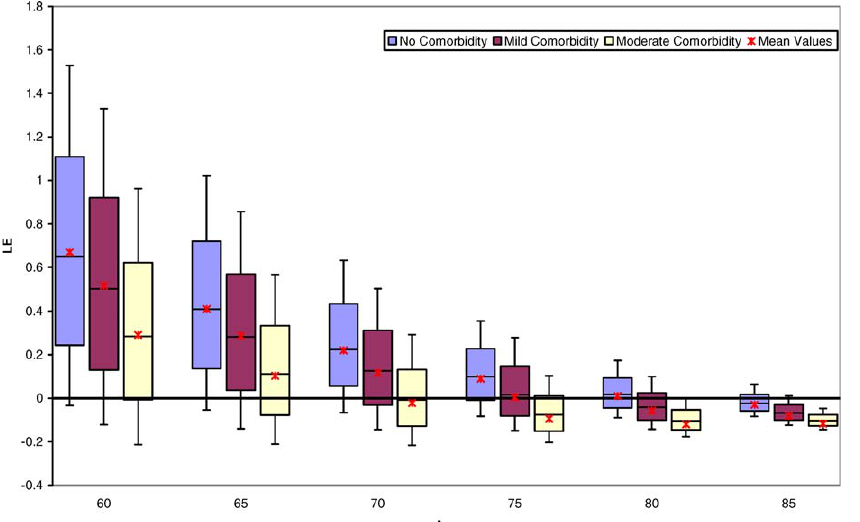
Figure 3. Box Plot of Gain in LE with Immediate Cystectomy by Age and Comorbid Status for Male Patients The region in the shaded boxes represents the interquartile range. The solid line within boxes is the median incremental gain, whereas the mean value is presented as an asterisk. Upper and lower whiskers indicate the 10th and 90th percentiles, respectively.